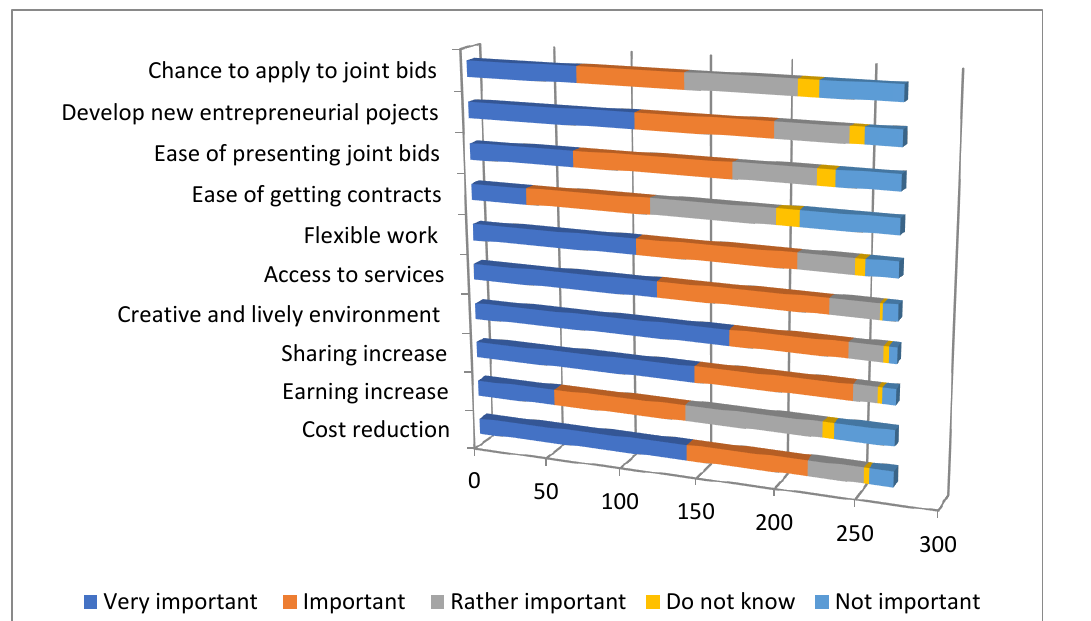
Figure. 1. Motivation for selecting the coworking space (pull factors) Source: Mariotti and Akhavan, 2020 (p.